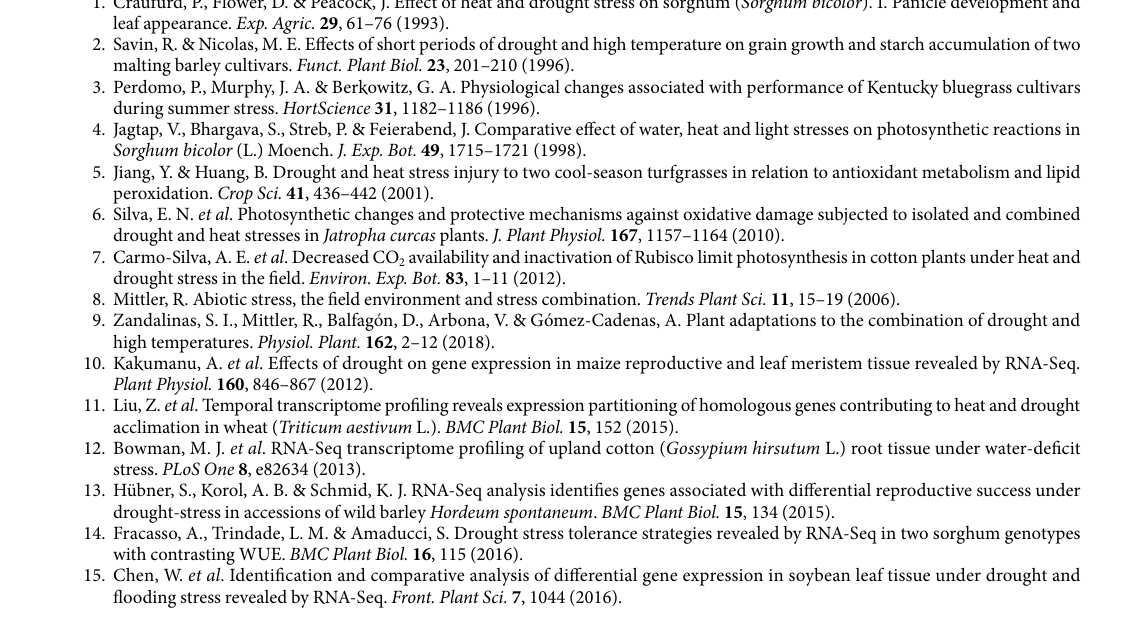
10 Scientific RePoRts | (2018) 8:15181 | DOI:10.1038/s41598-018-33597-3